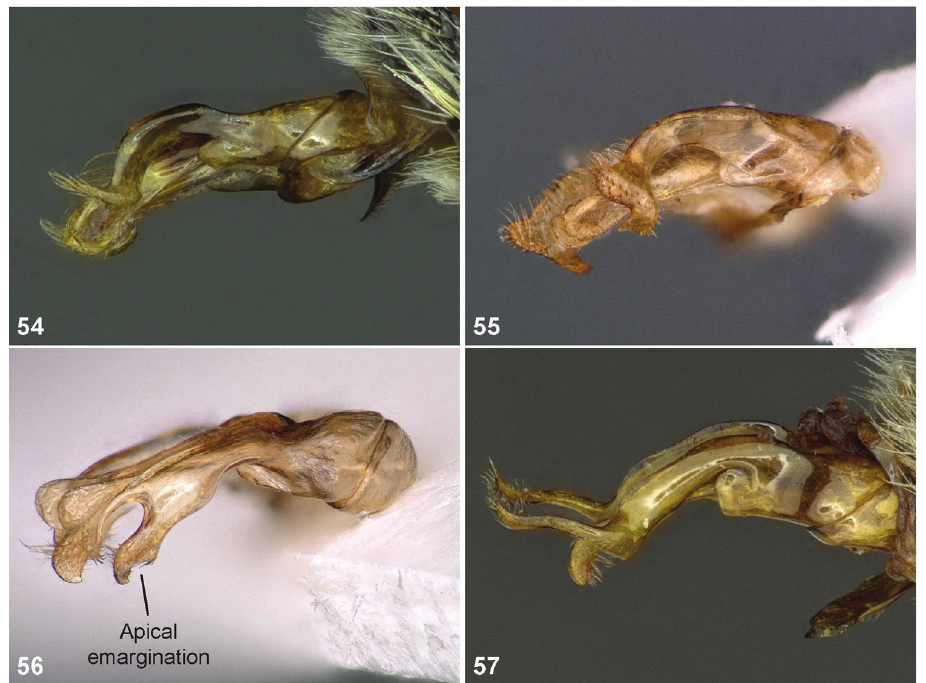
Figures 54–57. Genital capsule, lateral view. 54 Megachile ( Eutricharaea ) apicalis 55 M. ( Eutricharaea ) sp. aff. naevia 56 M. ( Eutricharaea ) leachella 57 M. ( Eutricharaea ) leucomalla